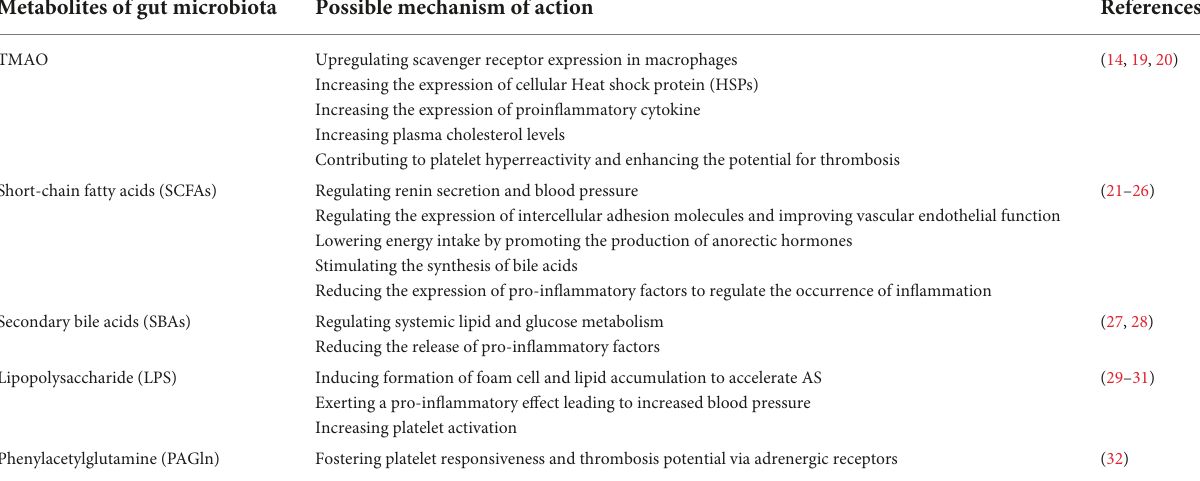
TABLE 6 Main metabolites of gut microbiota related to